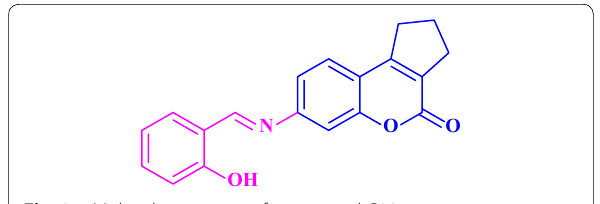
Fig. 81 Molecular structure of compound C93